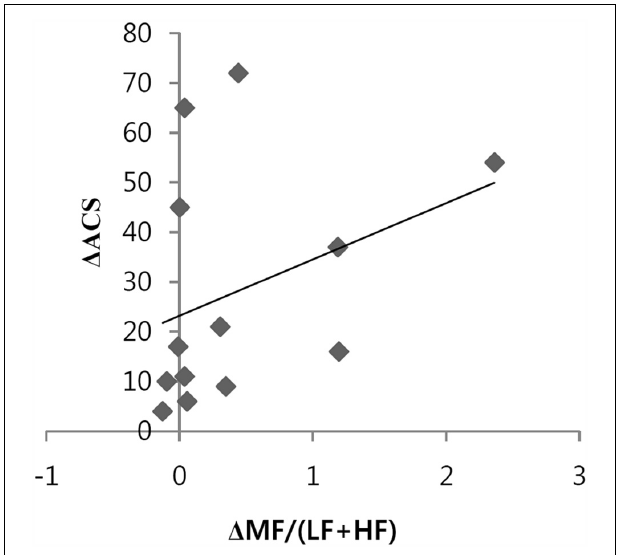
FIGURE 2 | Positive correlation between the changes of accumulative coherent scores (ACSs) and the changes in the MF/(LF + HF) ratios during 3 min epochs of heart coherent meditation compared to 3 min epochs of heart non-coherence at baseline ( n = 13, r = 0.581, p =